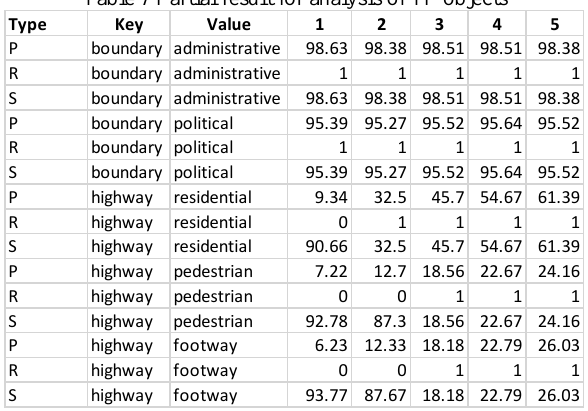
Table 7 Partial result for analysis of TP objects